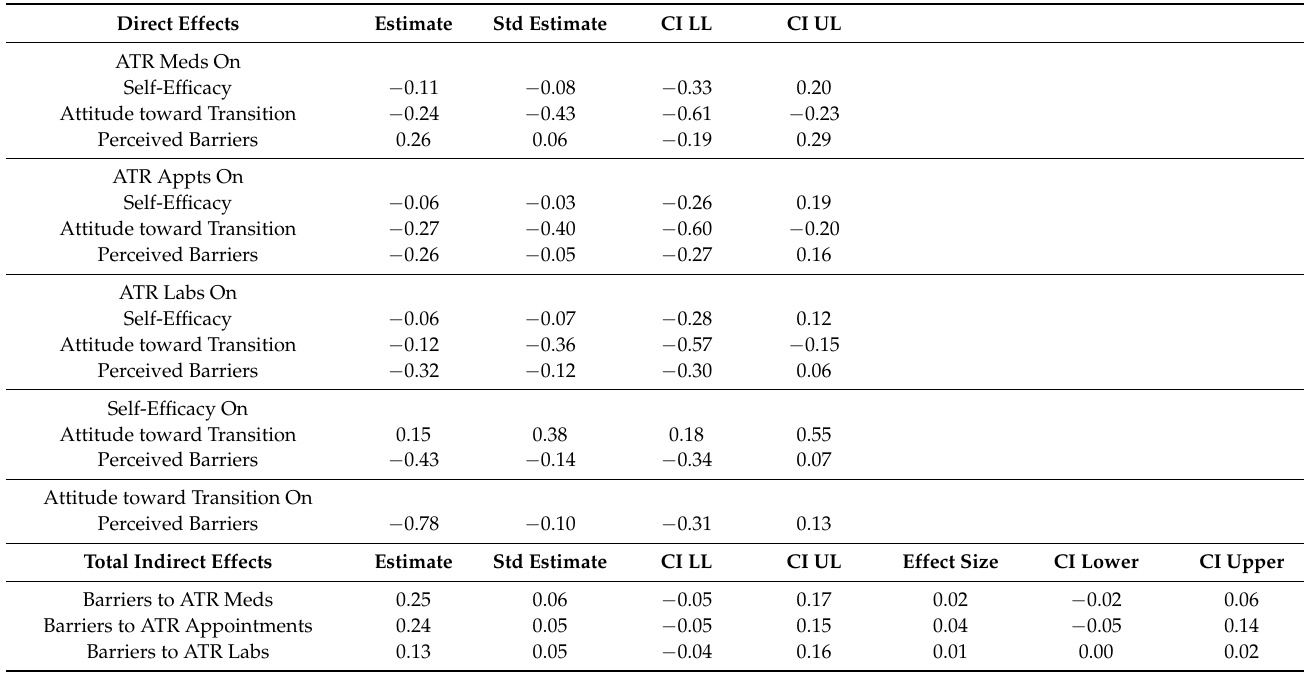
Table 4. Model 1 results: attitudes toward transition path model estimates of direct and indirect